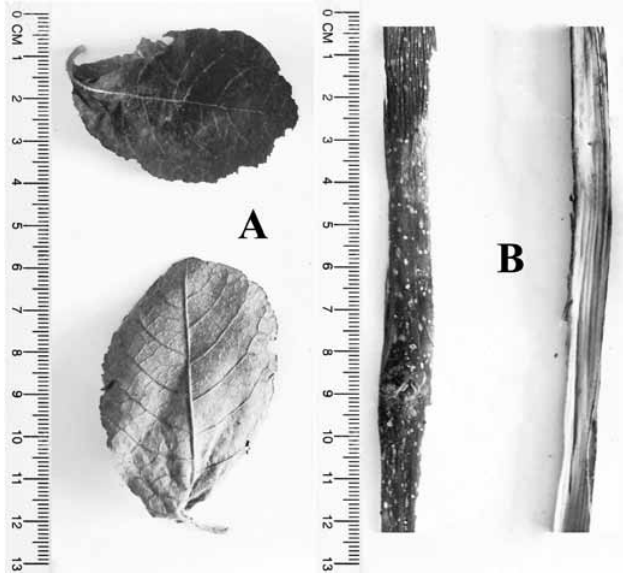
Fig. 2: Morphological traits of Brachylaena ramiflora leaves (A) and bark